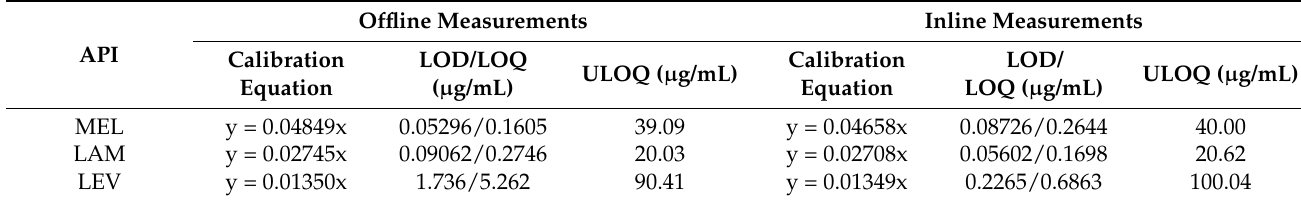
Table 5. Analytical parameters of the